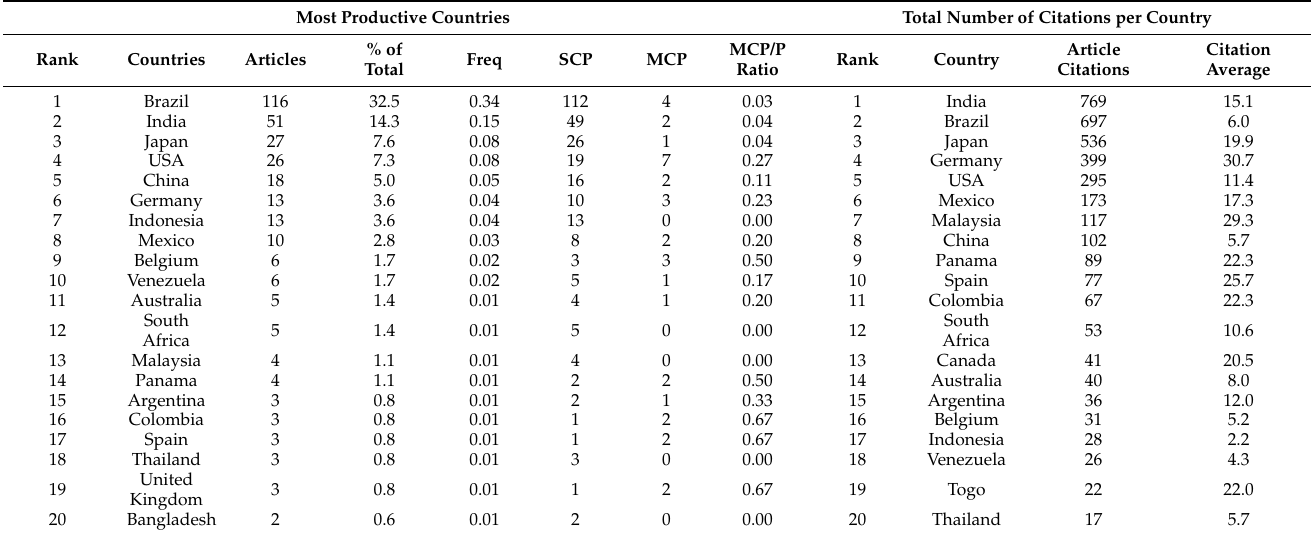
Table 2. Top 20 authors’ countries on studies related to the genus— Merremia from 1990–2020. SCP—single country publications. MCP—multiple country publications. MCP/P—multiple country publications per